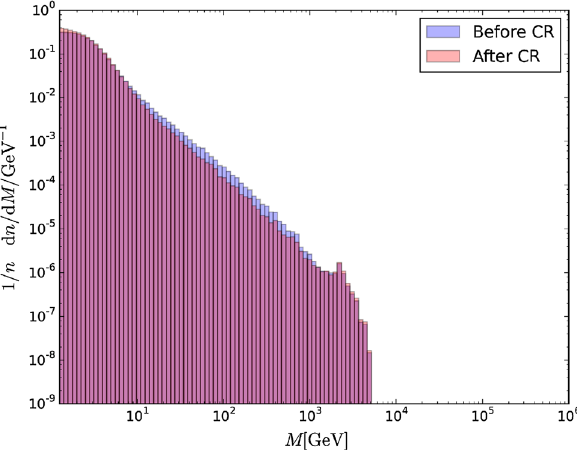
Fig. 17 Comparison between the distribution of invariant cluster masses after colour reconnection for the old model and the new model This could also in principle be solved in the framework of a colour reconnection model were many overlapping clusters (or a region of high cluster density) fuse together to form a heavy cluster which opens up the phase space for the produc- tion of strangeness and baryons in the cluster decay